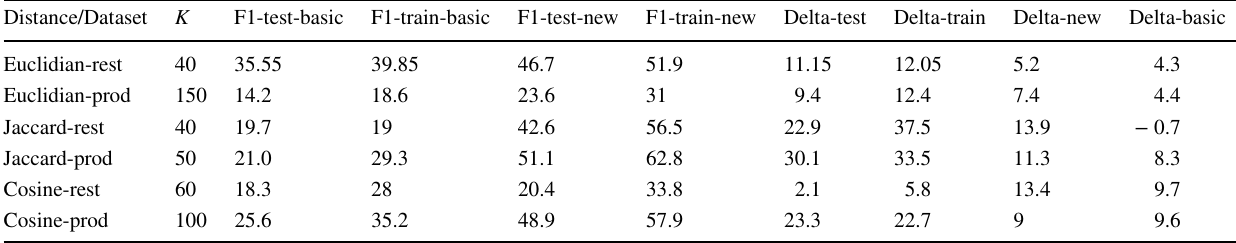
Table 5 F1-score average performances of NewKNN and BasicKNN in Underfitting, for both datasets and using three distances with tenfold cross-validation Distance/Dataset K F1-test-basic